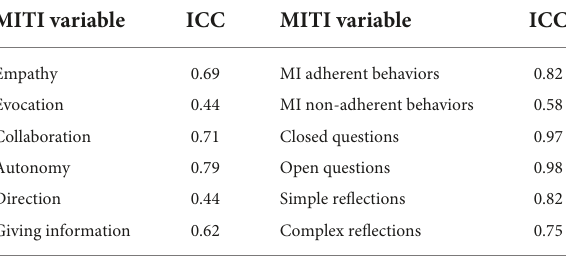
TABLE 2 The MIQA coder’s inter-rater reliability, assessed with a two-way mixed model with absolute agreement, single measures, ICC.